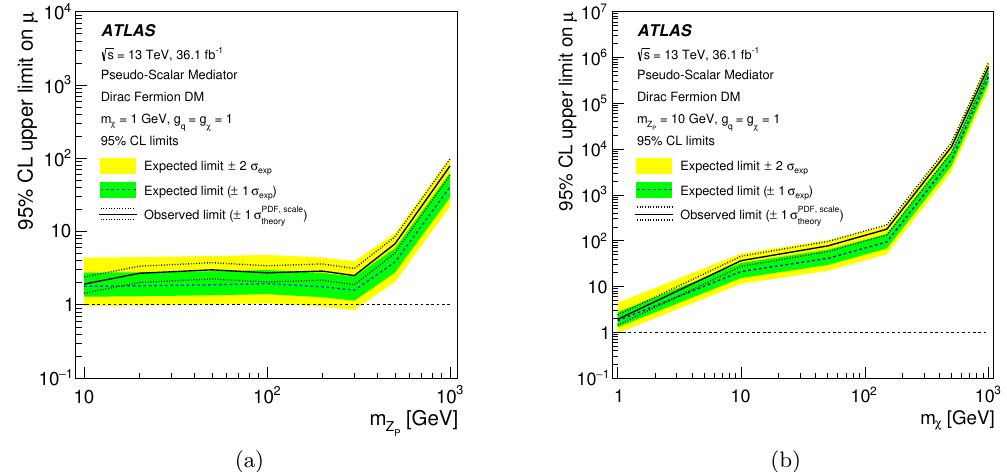
Figure 7 . Observed and expected 95 % CL limits on the signal strength (cid:22) (cid:17) (cid:27) 95% CL =(cid:27) as a function of (a) the mediator mass for a very light WIMP and (b) the WIMP mass for m Z in a model with spin-0 pseudoscalar mediator and g q = g (cid:31) = 1 : 0. The bands indicate the (cid:6) 1 (cid:27) theory uncertainties in the observed limit and the (cid:6) 1 (cid:27) and (cid:6) 2 (cid:27) ranges of the expected limit in the absence of a signal.